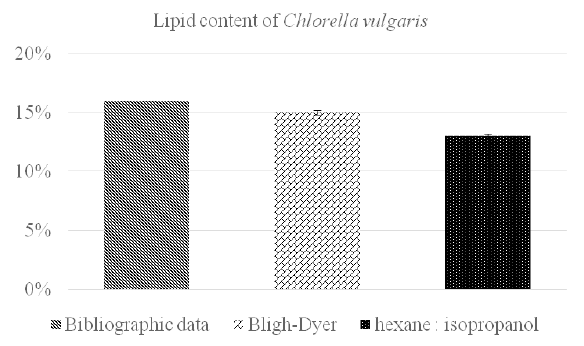
Figure 4: Lipid content of Chlorella vulgaris according to the extrac- tion method (Tokuşoglu and Ünal 2003) Decolourisation of oil. The decolourisation of lipid extract, using active carbon, was deemed successful if the colour of the final product closely resembled the colour of commercially available edible oils. Specifically, the colour of the bleached algal oil was similar to the colour of sunflower oil, while the initial colour of the oil was dark green. Despite the colour, the bleaching process enhanced the flavour of the oil, as chlorophyll decomposed to the pigment pheophytin, which is the main reason for the off-flavour of oils and their early oxidation (List 2009).